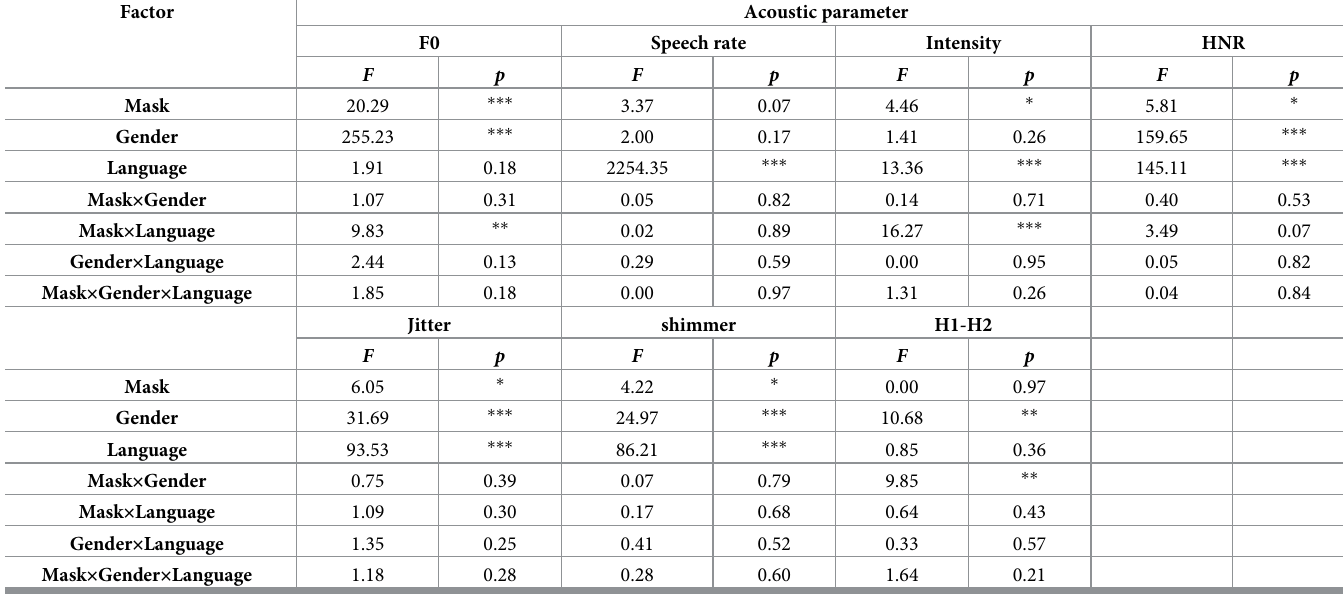
As for Speech rate, only a significant effect of “Language” was found. The post hoc test was not performed since no significance of the interested factor (i.e., “Mask”) was found. The significant main effect of “Mask” and “Language”, and the two-way interaction effect of “Mask × Language” were found for intensity. The post hoc test on the two-way interaction effect of “Mask × Language” showed that speech with face mask exhibited higher intensity than speech without face mask for Mandarin Chinese (mask-no mask: β = 0.97 dB, SE = 0.26, Table 2. Results of the linear mixed-effect models on the seven acoustic parameters with mask (with vs. without), gender (female vs. male), and language (Mandarin Chinese vs. English) as independent variables. The asterisks indicate the levels of statistical significance: * p < 0.05; ** p < 0.01; *** p < 0.001. Factor Acoustic parameter F0 Speech rate Intensity HNR